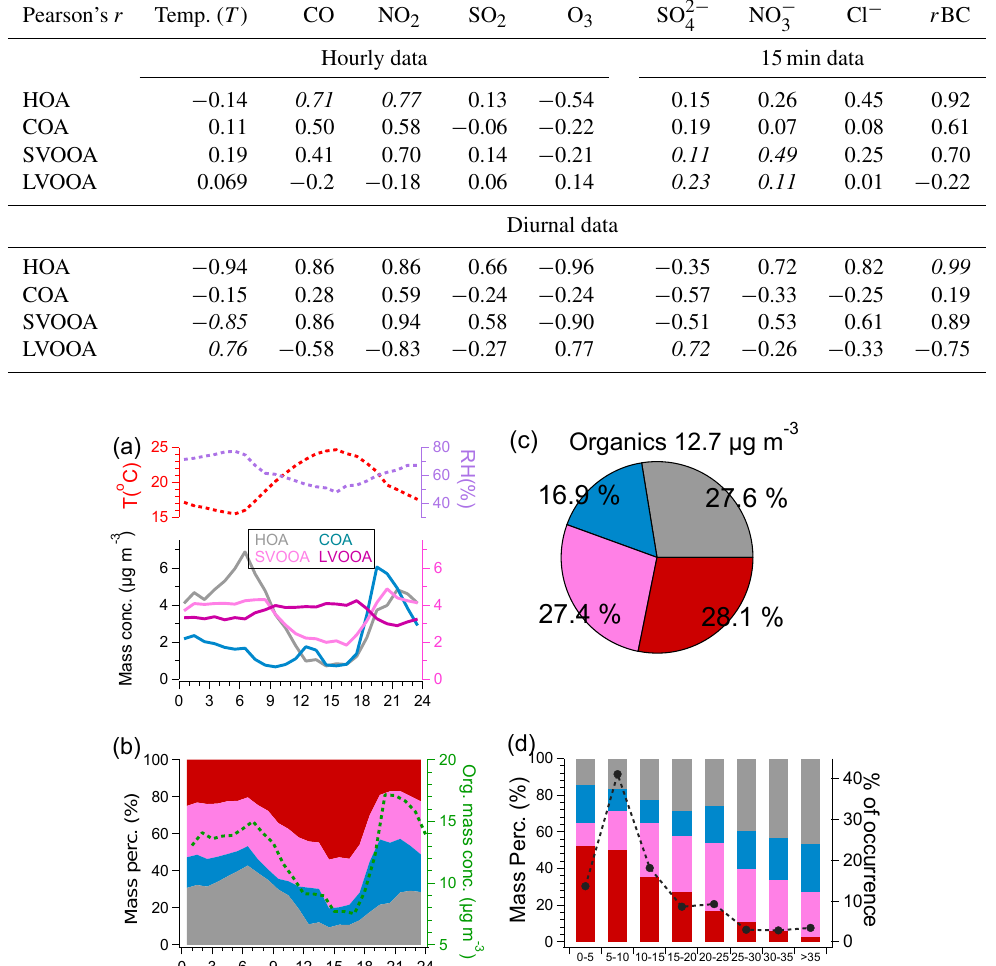
Table 2. Correlation coefficients (Pearson’s r ) between the time series of the four OA factors with the gas-phase species (hourly data) and other PM 1 components (15min data), and the correlation coefficients between the diurnal data (values in italic are significant ones and are discussed in details in the text ).